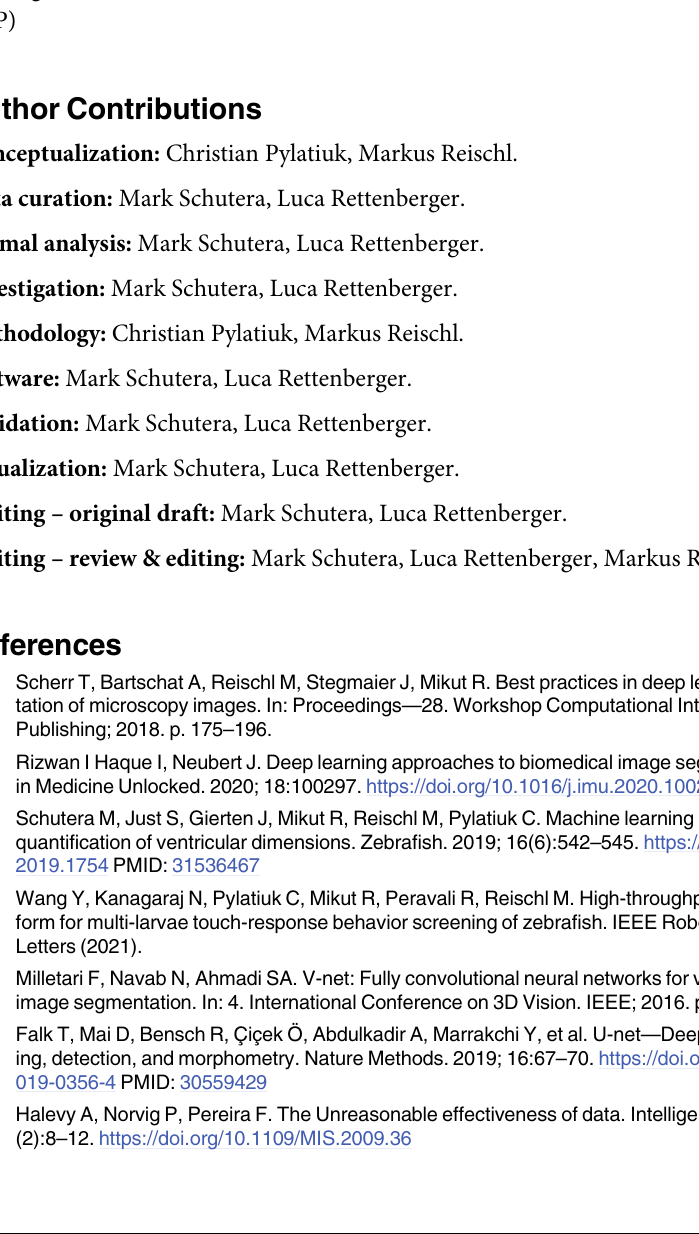
S1 File. Detailed information on the conducted experiments. Table 1: General ablation study. Table 2: Extend dataset by an additional class. Table 3: Merge two datasets. Table 4: Trading off horizontal with vertical